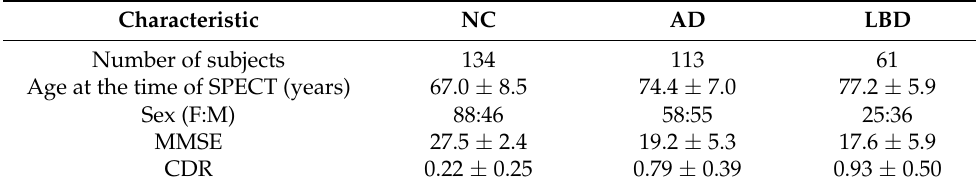
Table 1. Demographic and clinical characteristics of Tc-99m-ECD SPECT data.